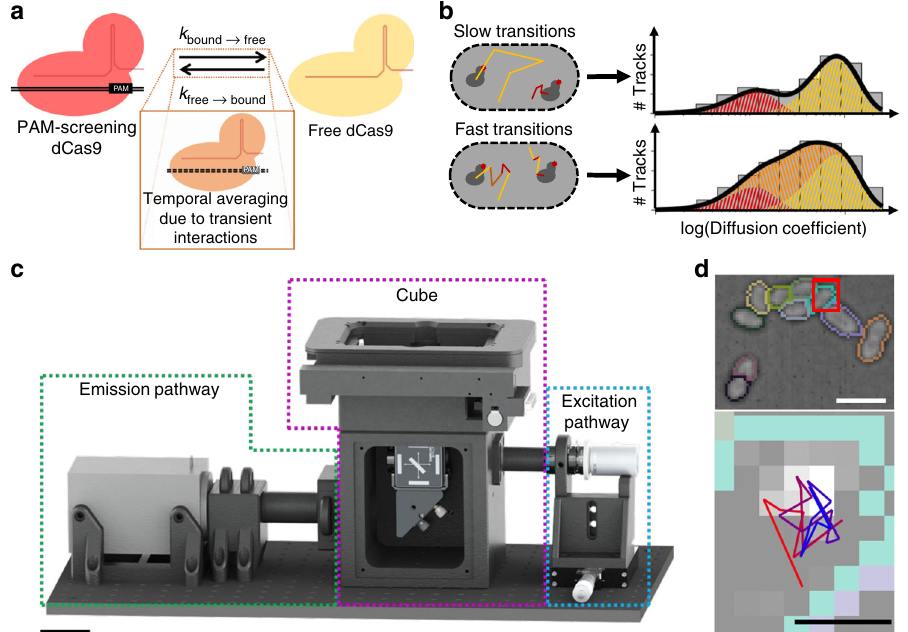
Fig. 1 Probing cellular dynamics of dCas9 on an open-source microscope using sptPALM. a Simpli fi ed expected dynamic behaviour of dCas9 in absence of DNA target sites. The protein can be temporarily bound to DNA (PAM screening), or diffuse freely in cytoplasm, with two kinetic rates governing the dynamics. If the interaction is on a similar timescale as the detection time, a temporal averaging due to transient interactions is expected. b If the dynamic transitions are slow with respect to the camera frame time used in sptPALM, the obtained diffusional data can be fi tted with a static model (top), which assumes that every protein is either free (yellow) or DNA-bound (red), but does not interchange. If the dynamic transitions are as fast or faster than the frame time used, Monte-Carlo diffusion distribution analysis (MC-DDA; bottom) can fi t the diffusional data. In MC-DDA, dCas9 can interchange between the two states, resulting in a broader distribution. c Render of the open-source miCube super-resolution microscope. The excitation components, main cube, and emission components are indicated in blue, magenta, and green, respectively. Details are provided in the “ Methods ” section. Scale bar represents 5 cm. d Bright fi eld images of L. lactis used for computationally obtaining the outline of the cells via watershed (top), and raw single molecule data (bottom; red outline in top is magni fi ed) as obtained on the miCube as part of a typical experiment, overlaid with the determined track where this single molecule belongs to (starting at red, ending at blue). Scale bars represent 2.5 µ m (top) or 500 nm